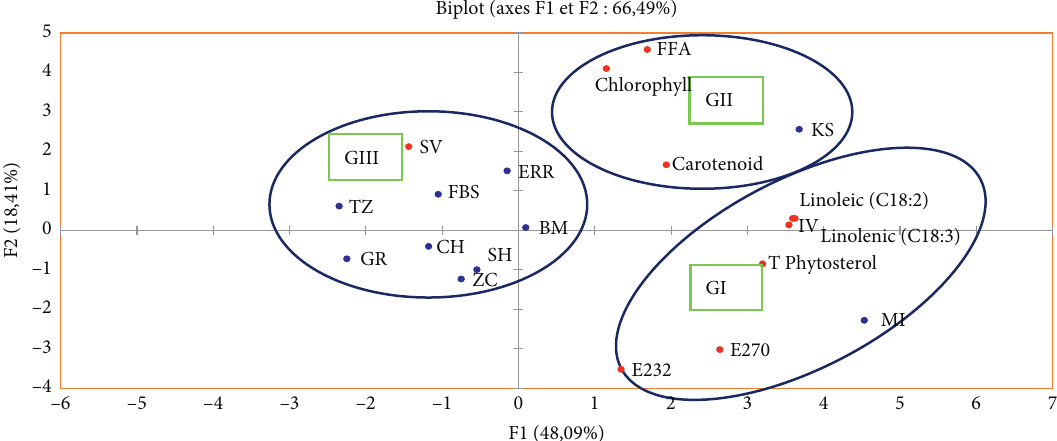
Figure 5: Projection of individuals on the factorial plan (F1 × F2). GI: Group I; GII: Group II; GII: Group